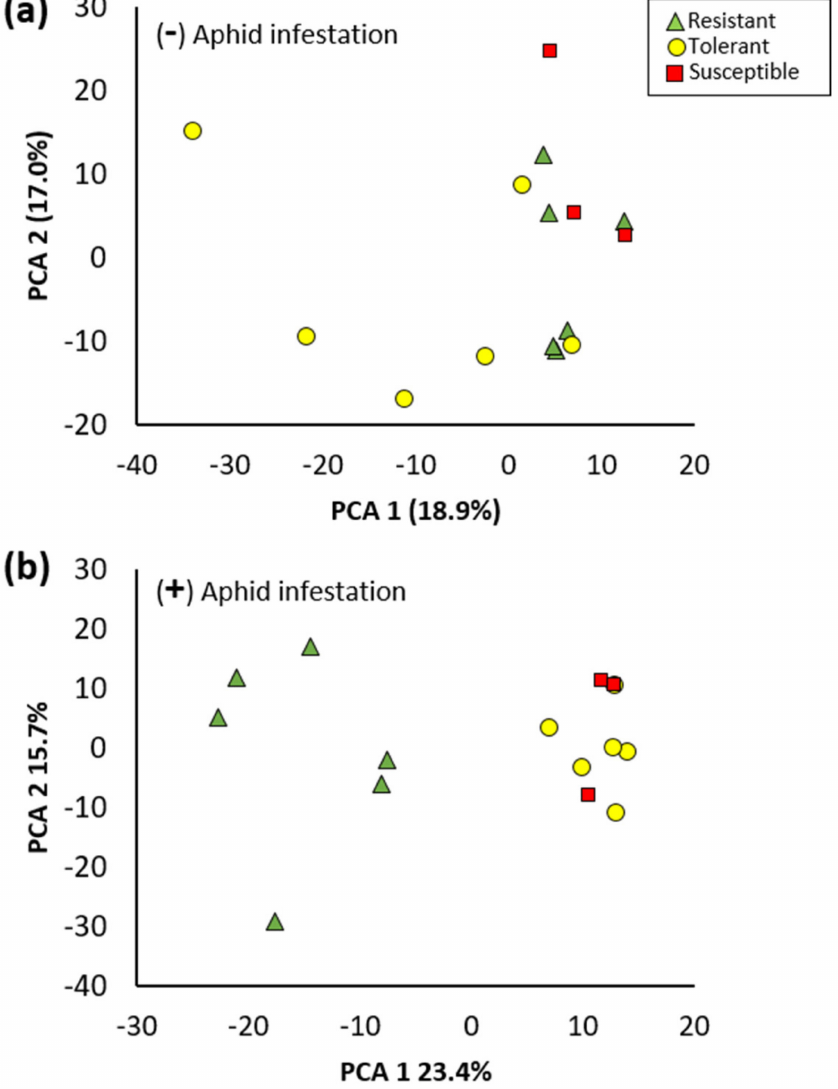
Figure 6. PCA plots derived from metabolite features in the ( a ) absence of aphids and ( b ) presence of